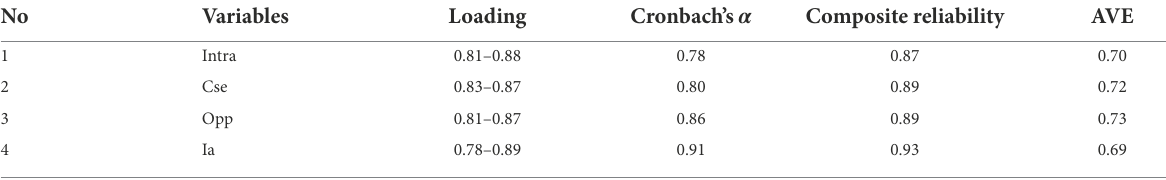
TABLE 2 Factor loadings, Cronbach’s alpha ( α ), composite reliability, and average variance extracted (AVE).